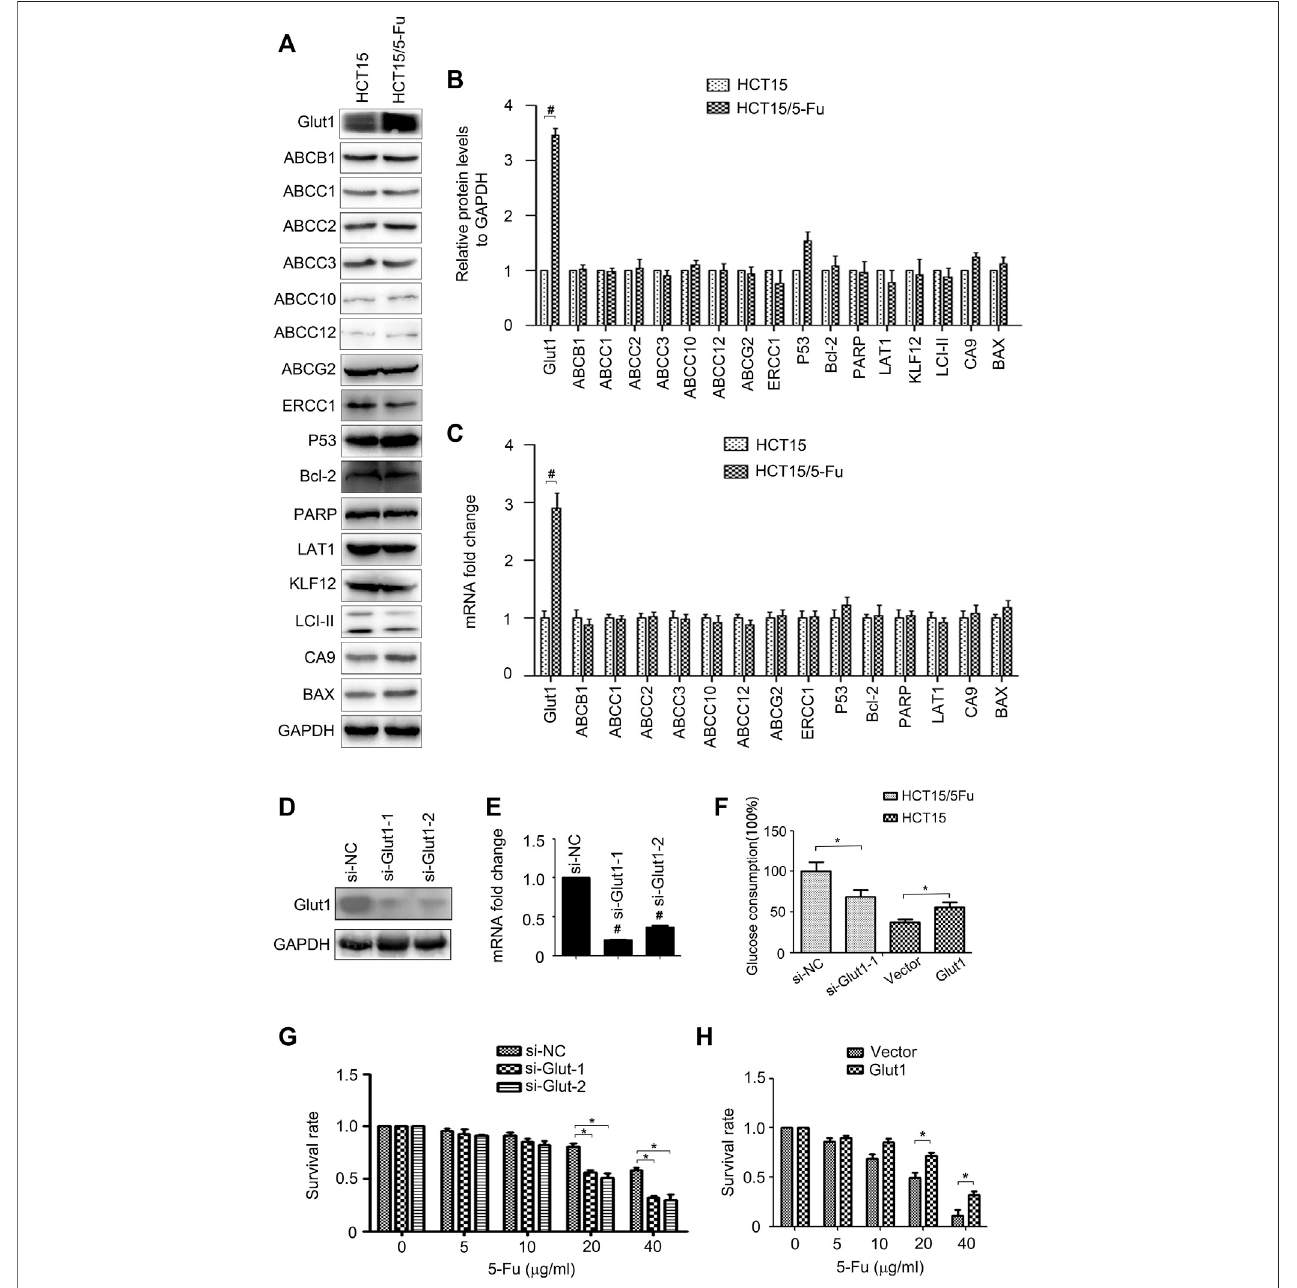
FIGURE 2 | Glut1 maintains the resistance phenotype of 5-Fu resistant CRC cells. (A,B) The protein expression of Glut1, ABCB1, ABCC1, ABCC2, ABCC3, ABCC10,ABCC12,ABCG2,ERCC1,P53,Bcl-2,PARP,LAT1,KLF12,LCI-II,CA9andBAXinHCT15andHCT15/5-FucellswereexaminedbyWB.GAPDHserversas the loading control. (C) The mRNA expression of Glut1, ABCB1, ABCC1, ABCC2, ABCC3, ABCC10, ABCC12, ABCG2, ERCC1, P53, Bcl-2, PARP, LAT1, CA9 and BAXininHCT15andHCT15/5-FucellswereexaminedbyRT-PCR. (D,E) ExpressionofGlut1proteinandmRNAinHCT15/5-Fucellstransfectedwithsi-NCorsi- Glut1 for 24 h were detected by WB and quantitative RT-PCR, respectively. (F) Glucose concentration in the supernatants was measured in HCT15/5-Fu cells transfected with si-NC or si-Glut1 and HCT15 cells transfected with control vector plasmid or pcDNA-Glut1. (G) HCT15/5-Fu cells were transfected with si-NC or si- Glut1 for 24 h were treated with increasing concentrations of 5-Fu for 48 h. CCK8 assay was used to quantify the viable cells. (H) HCT15 cells were transfected with control vector plasmid or pcDNA3.1-Glut1 for 24 h were treated withincreasing concentrations of5-Fu for 48 h. CCK8 assay was used to quantifythe viable cells. Data represented as mean ± SD were from three independent experiments. *: p < 0.05, #: p < 0.01. si-NC: negative control siRNA.